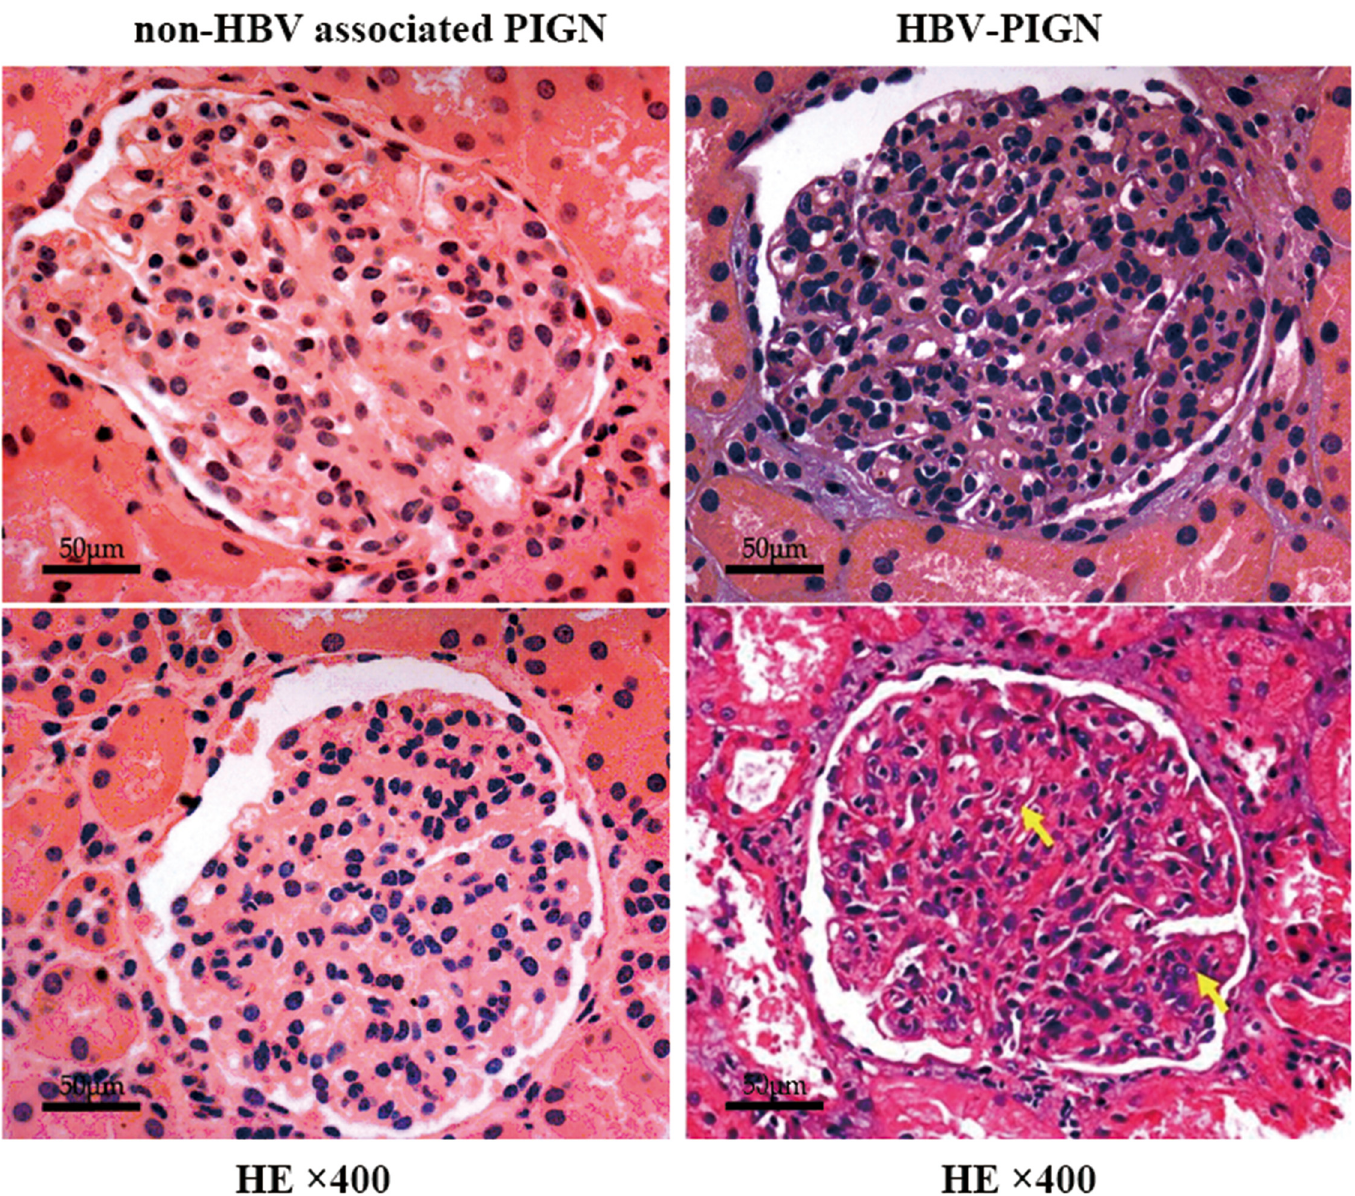
Fig 1. Diffuse endocapillary proliferation in HBV-PIGN and non-HBV associated PIGN: Representative glomerular pathology shows increased cell counts in both the glomerular capillary and mesangium (arrows). The opening of glomerular capillary is noticeably reduced in breadth. Glomerular pathology was indistinguishable between non-HBV associated PIGN (A, B) and HBV-PIGN (C,